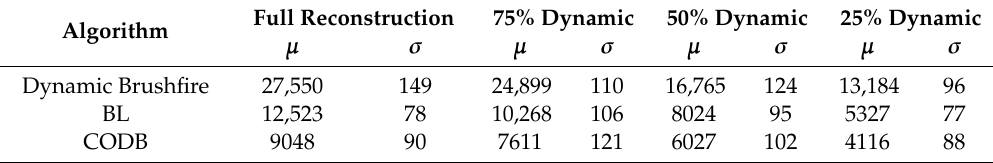
Table8. Comparisonofthemaximalsizeofthepriorityqueue OPEN (Onlydynamicalgorithmsarecompared). Table 7. Comparison of the algorithms’ efficiencies in the four scenarios (milliseconds). Algorithm